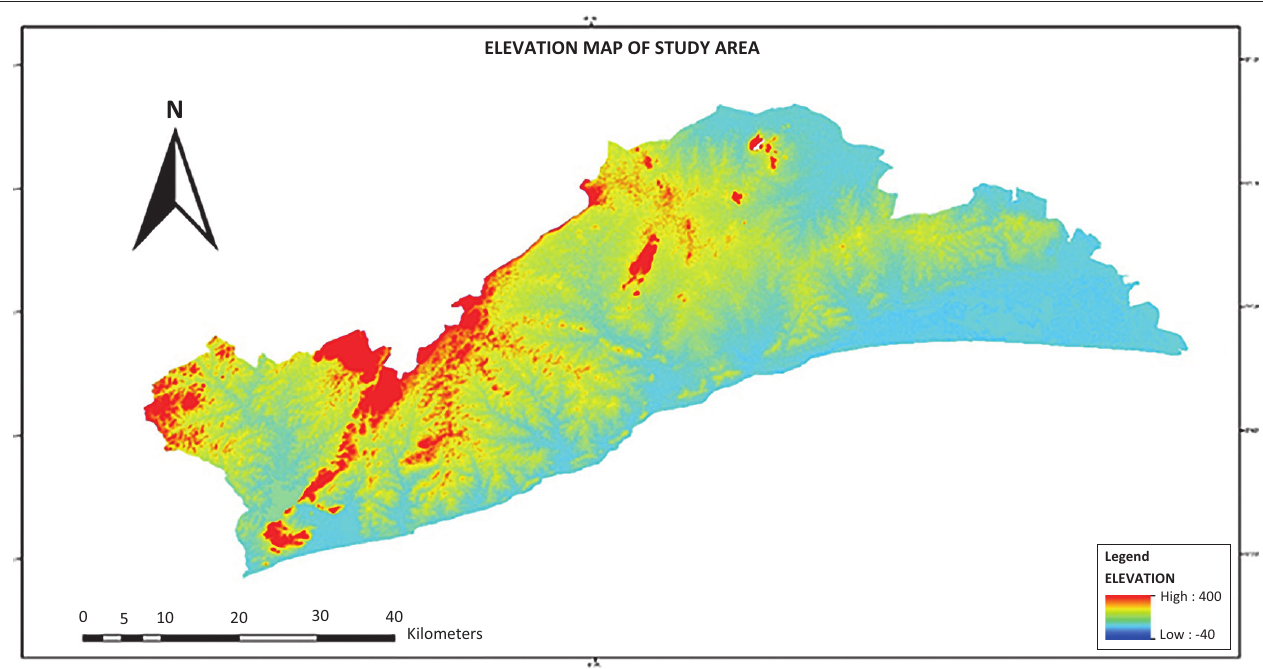
FIGURE 5: Digital elevation map of the study